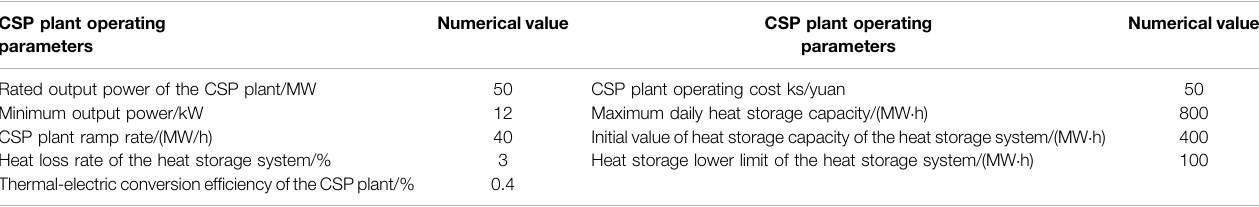
TABLE 2 | Operation parameters of